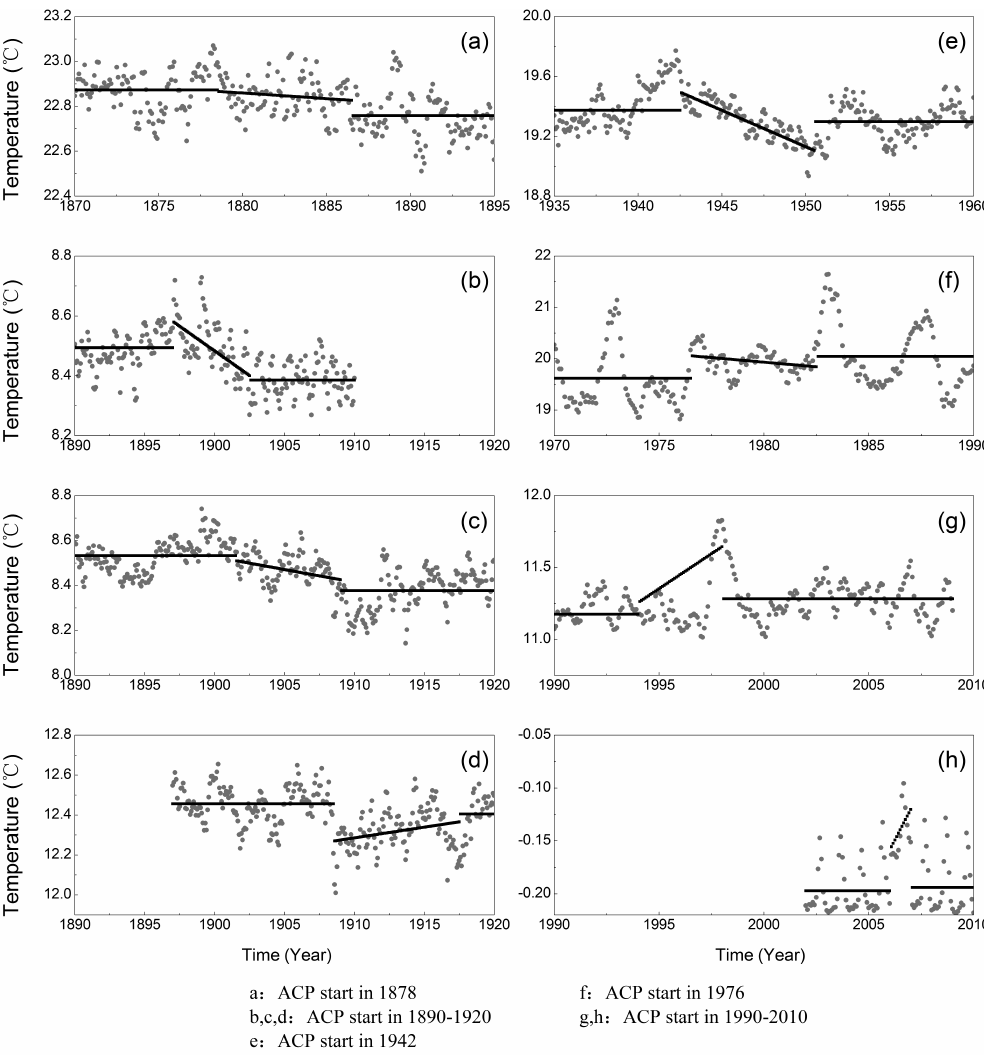
Figure 3. Time sequence average of abrupt changes occurring under the background of the same abrupt change: (a) is the abrupt change starting in 1878; (b–d) is the abrupt change occurring in 1890–1920, including the following: (e) is the abrupt change starting in 1942, (f) is the abrupt change starting in 1976, and (g–h) is the abrupt change starting in